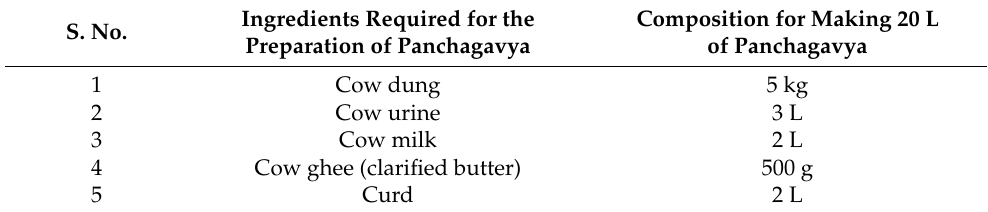
Table 1. Composition of panchagavya.